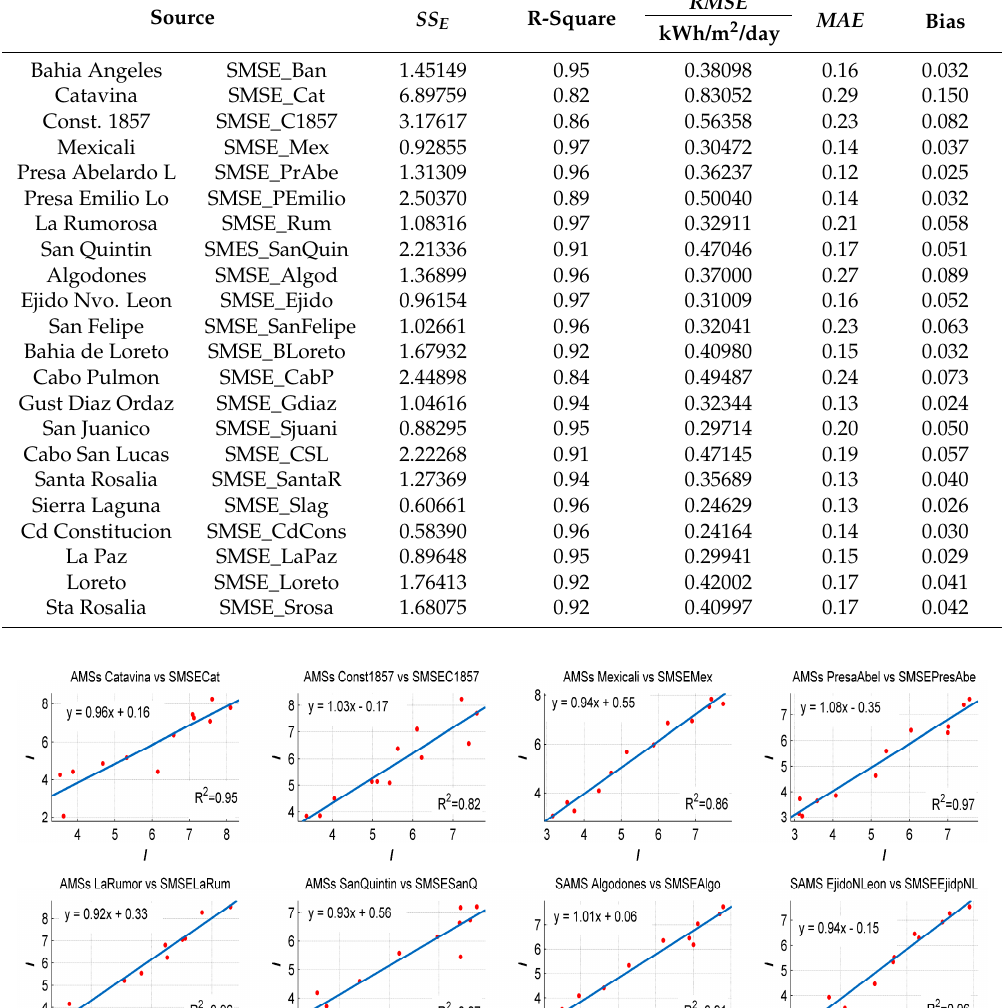
Table 2. Statistic parameters of AMSs and SAMSs versus SMSE data.